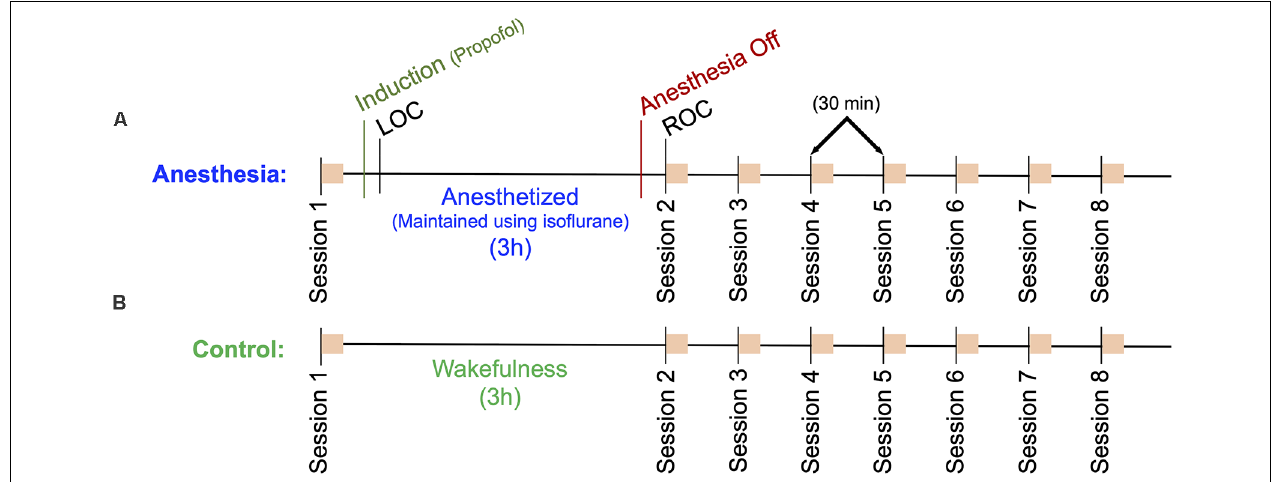
FIGURE 1 | Outline of the experimental protocol. Eight sessions consisting of a battery of six neurocognitive tests are indicated as orange squares. (A) Anesthesia group protocol. A baseline cognitive test battery (Session 1) was followed by a 15-min propofol induction and a 3 h anesthesia using isoflurane. Session 2 cognitive tests commenced immediately upon recovery of consciousness (ROC), sessions 3–8 followed at 30-min intervals. (B) Control group protocol. A baseline cognitive test battery (Session 1) followed by a 3-h period of wakefulness, where participants read a book, watched a movie, or engaged in other wakeful behavior. Sessions 2–8 were then completed at 30 min intervals. High density EEG was recorded throughout the protocol for both groups.